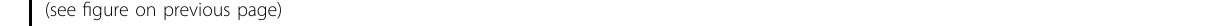
Fig. 4 Selective and conditional inhibition of the NF-kB pathway in β -cells during adulthood has no effect on glucose tolerance or insulitis in the transgenic NOD/ToI β mice. A Experimental design: NOD/ToI β female mice were exposed to Dox from weaning to 35 weeks. B – D IPGTT was performed at 4 ( B ), 9 ( C ) or 14 ( D ) weeks of age. The results are presented as the mean ± SEM of data pooled from untreated controls (circles, n = 10 – 16), Dox-treated 3 – 35 weeks (triangles, n = 8 – 11). E – G Insulitis was assessed using hematoxylin and eosin staining of histological sections of the pancreata of untreated (empty bars) or Dox-treated (black bars) mice. Insulitis score was calculated as a percent of total islets per mouse at ( E ) 4 weeks: control, (487 islets, n = 5) and 3 – 35 weeks (329 islets, n = 4); at ( F ) 9 weeks: control (249 islets, n = 4) and 3 – 35 weeks (355 islets, n = 4); and at ( G ) 14 weeks: control (336 islets, n = 5) and 3 – 35 weeks (361 islets, n = 5). Values are mean ± SE. H Pictures are representative confocal images of islets from three to four different mice per group taken at 9 weeks of age. For each mouse, ~20 islets were analyzed. Pancreata were immunostained for p65 (red), insulin (green), and DNA (blue). Original images were taken at a magni fi cation of ×40.